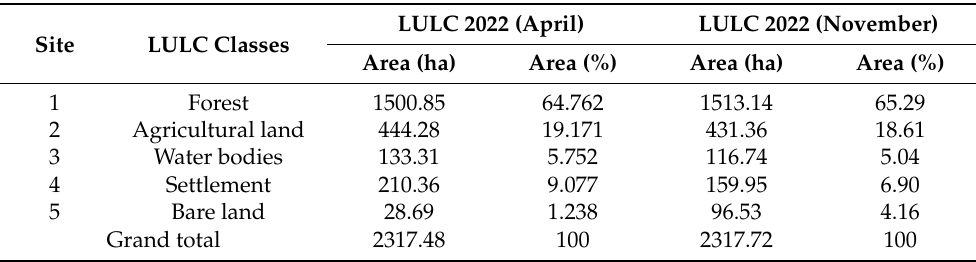
Table 2. Land use and land cover (LULC) change in Ghodaghodi Lake Complex, Nepal, between April and November 2022.